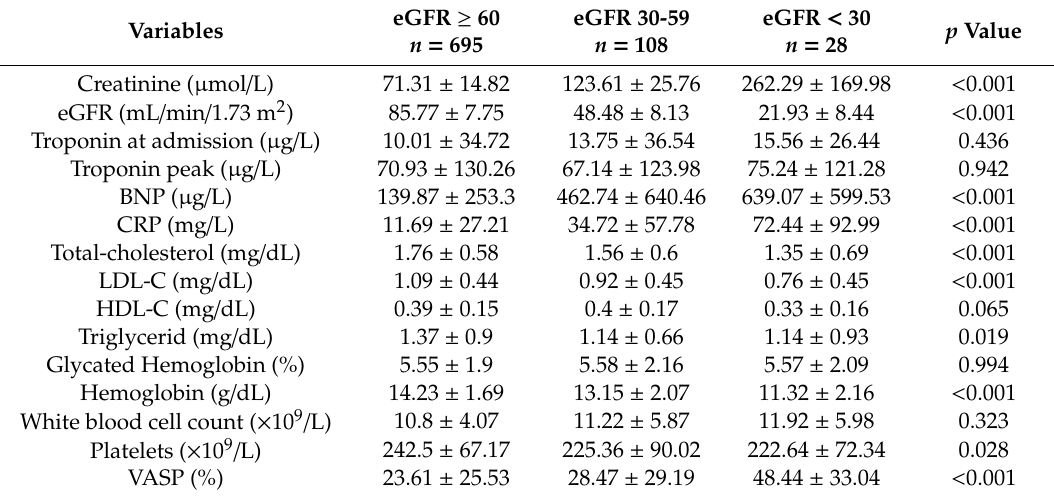
Table 2. Biological parameters according to renal